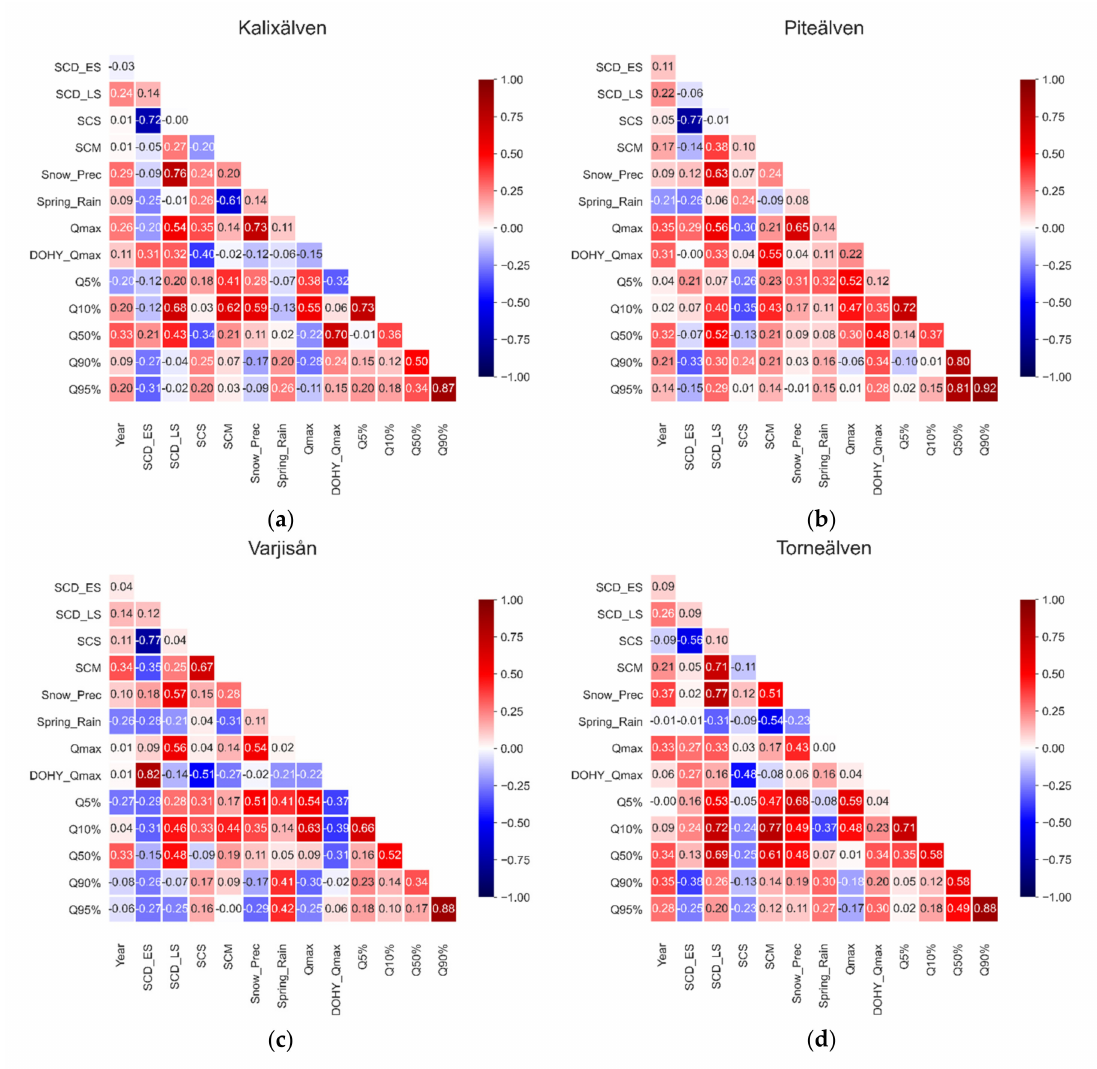
Figure 12. Correlation matrices for the timing measures of ( a ) Kalixälven, ( b ) Piteälven, ( c ) Varjisån, and ( d )